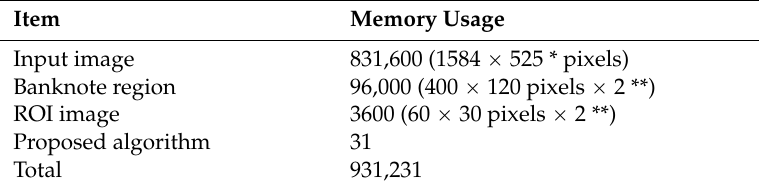
Table 9. Memory usage of the proposed algorithm in a banknote counting machine. (unit: